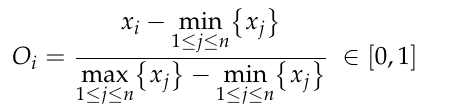
Table 2. Sample table of teacher training